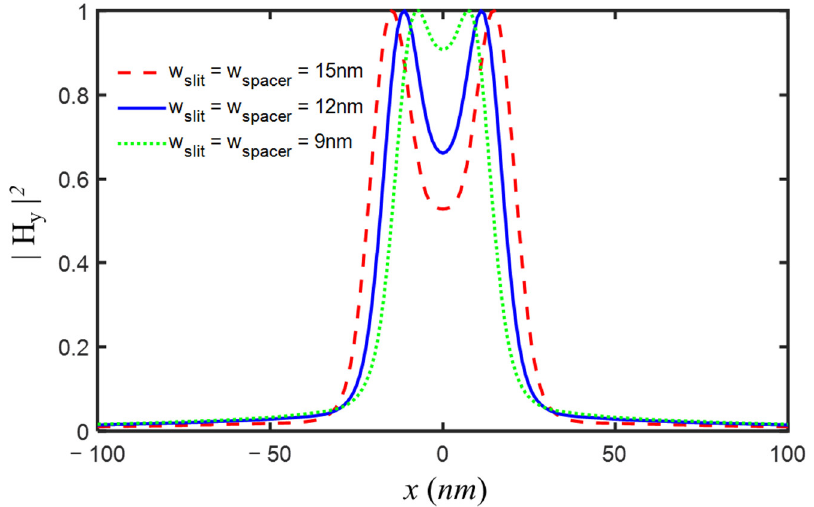
Figure 10. The images of two-slit object with slit width and spacer width of 15 nm, 12 nm, and 9 nm, for designed imaging system with the following parameters: ε s 1 = ε s 2 = − 4.43 + i 0.42, ε p = 4.58, ε d = 4.08, ε q = 2.89, d s 1 = d s 2 = d p = d d = d q = 5